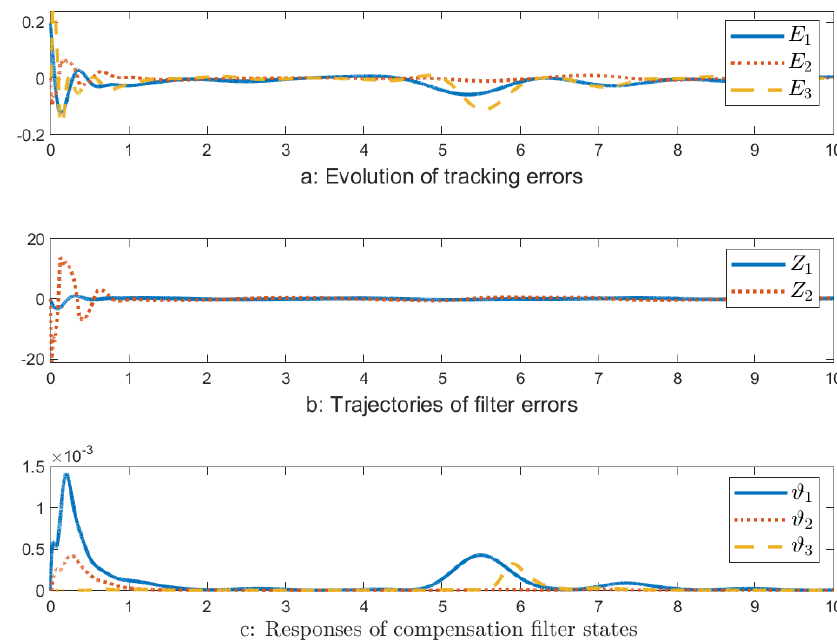
Figure 4. Curves of error signals and compensation filter